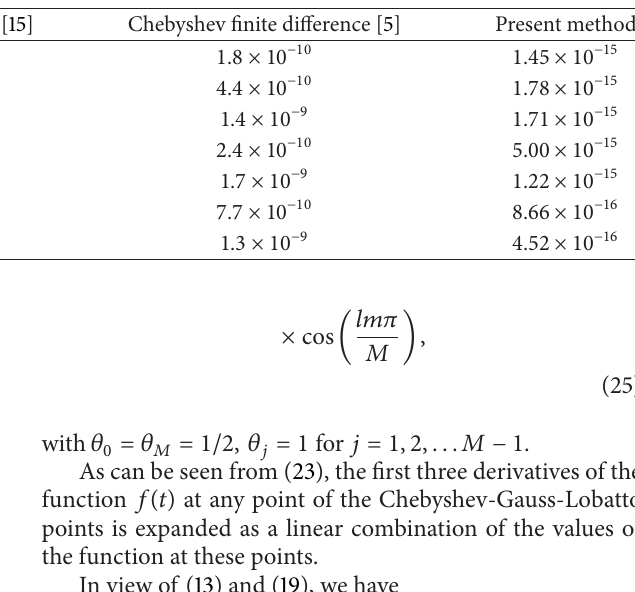
Table 3: A comparison of absolute errors between Wc, WG, Cfd, and present method.